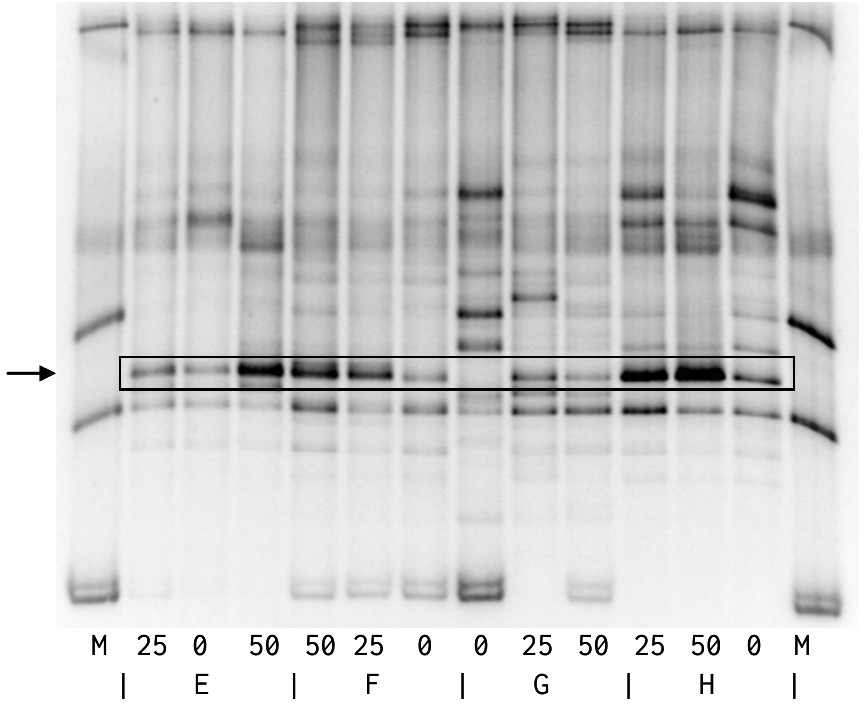
Figure 2. Effects of RM on microbiota . DGGE profiles for subjects E, F, G, H on Day 24 during placebo (0), RM 25 (25) and RM 50 (50) intervention periods. M = molecular marker, black arrow indicates position of band increased during RM supplementation (box). DNA was eluted from the marked band and submitted to sequencing. DGGE gels were run and diversity in each profile was calculated as described in Figure 1. Profiles for each individual are presented in the order that they received each